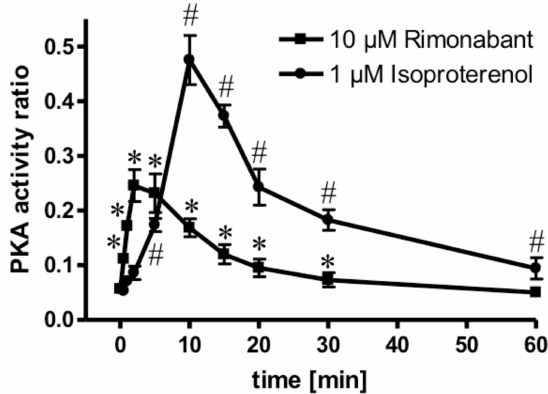
Figure 5. Activation of PKA by Rimonabant during adipocyte lipolysis. Primary rat adipocytes were incubated (37 ◦ C) in the absence or presence of 1 µ M isoproterenol ( • ) or 10 µ M Rimonabant ( (cid:4) ) for increasing periods of time and then rapidly deep-frozen. After preparation of cytosolic fractions, identical amounts of protein were assayed for the PKA activity ratio (see Materials and Methods). The portion of PKA activated at the time point of deep-freezing of the adipocytes was calculated as the ratio of Kemptide phosphorylated in the absence and presence of cAMP. Mean ± SD of three incubations with electrophoretic separations in duplicate. * (10 µ M Rimonabant), # (1 µ M Rimonabant) p ≤ 0.01 vs. time